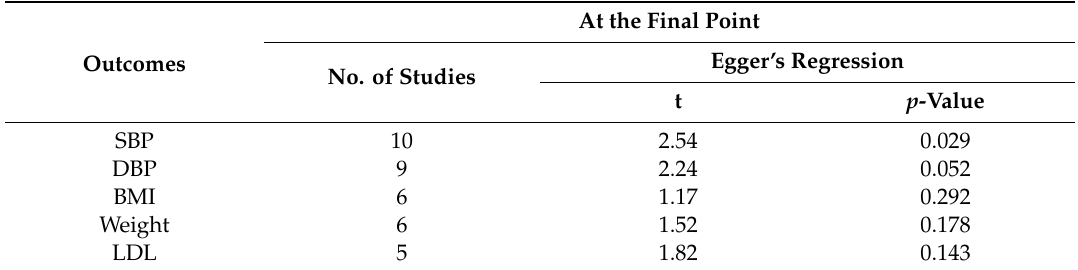
Table 3. Results of publication bias by Egger’s regression test at the final